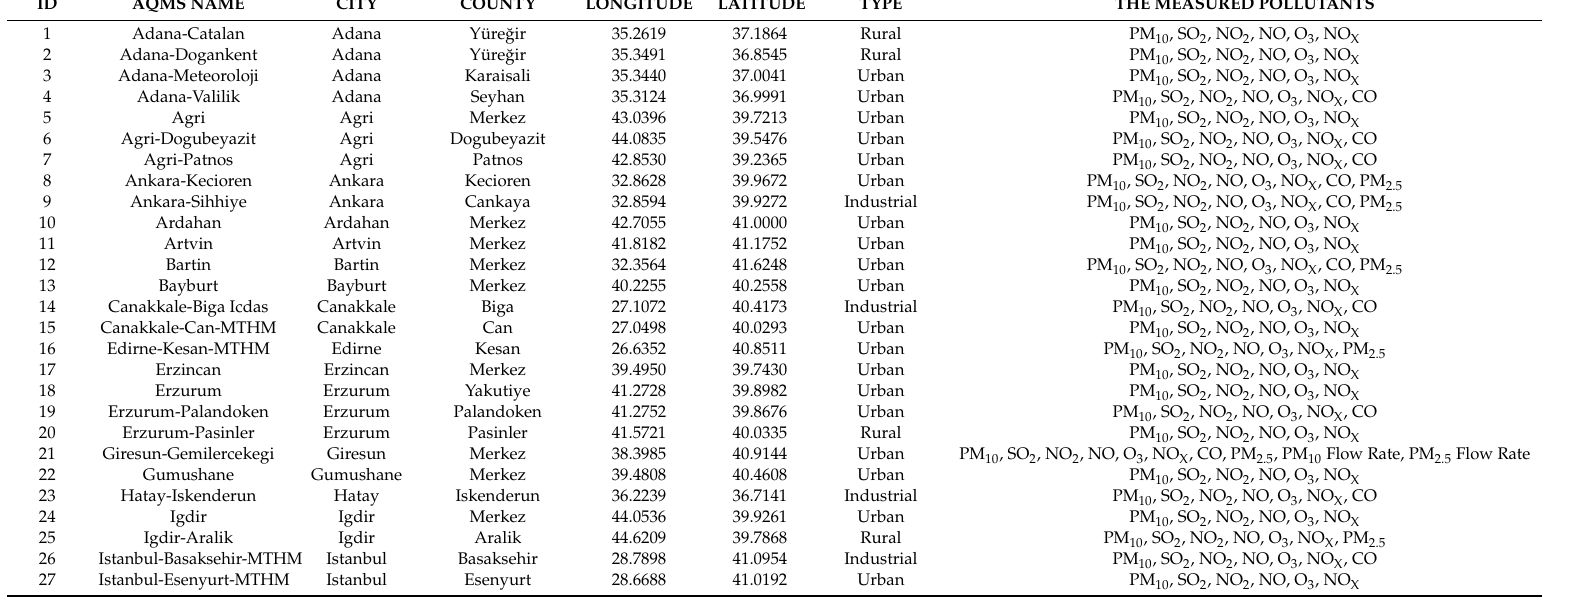
Table 6. The selected air quality monitoring stations (AQMS) and their